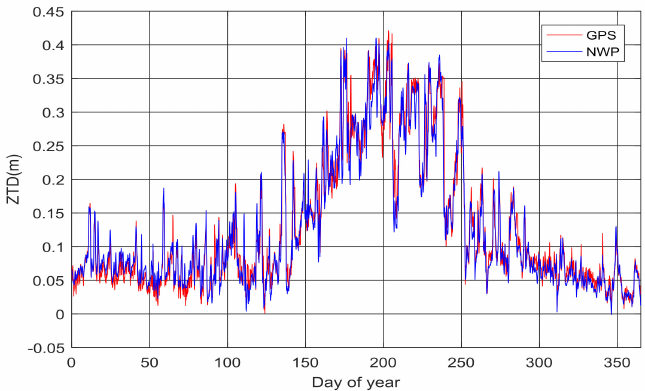
Figure 4. Time series of NWP ZTD (blue line) and GAMIT ZTD (red line) at station